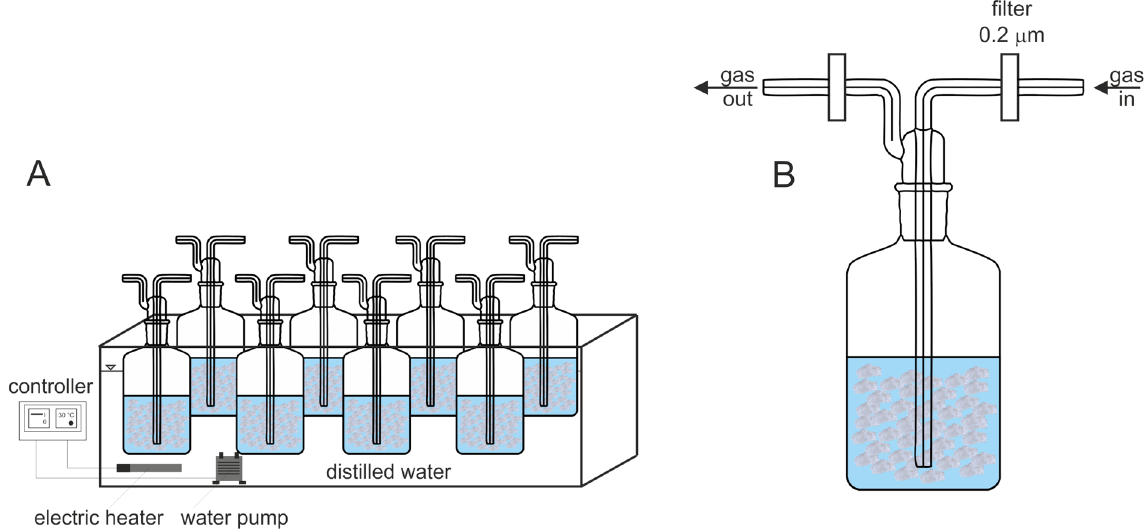
Fig. 2 Experiment design setup; A water bath with eight gas wash bottles according to Drechsel and system for water heating and mixing; B clear 500 ml gas wash bottles according to Drechsel, with indication of air flow, showing medium and virgin HDPE